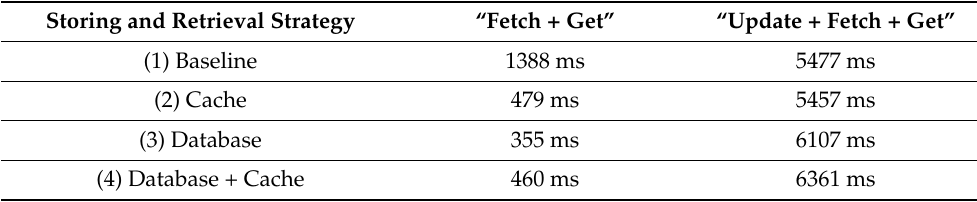
Table 3. Comparison of database storing and caching of User rating, time for 1000